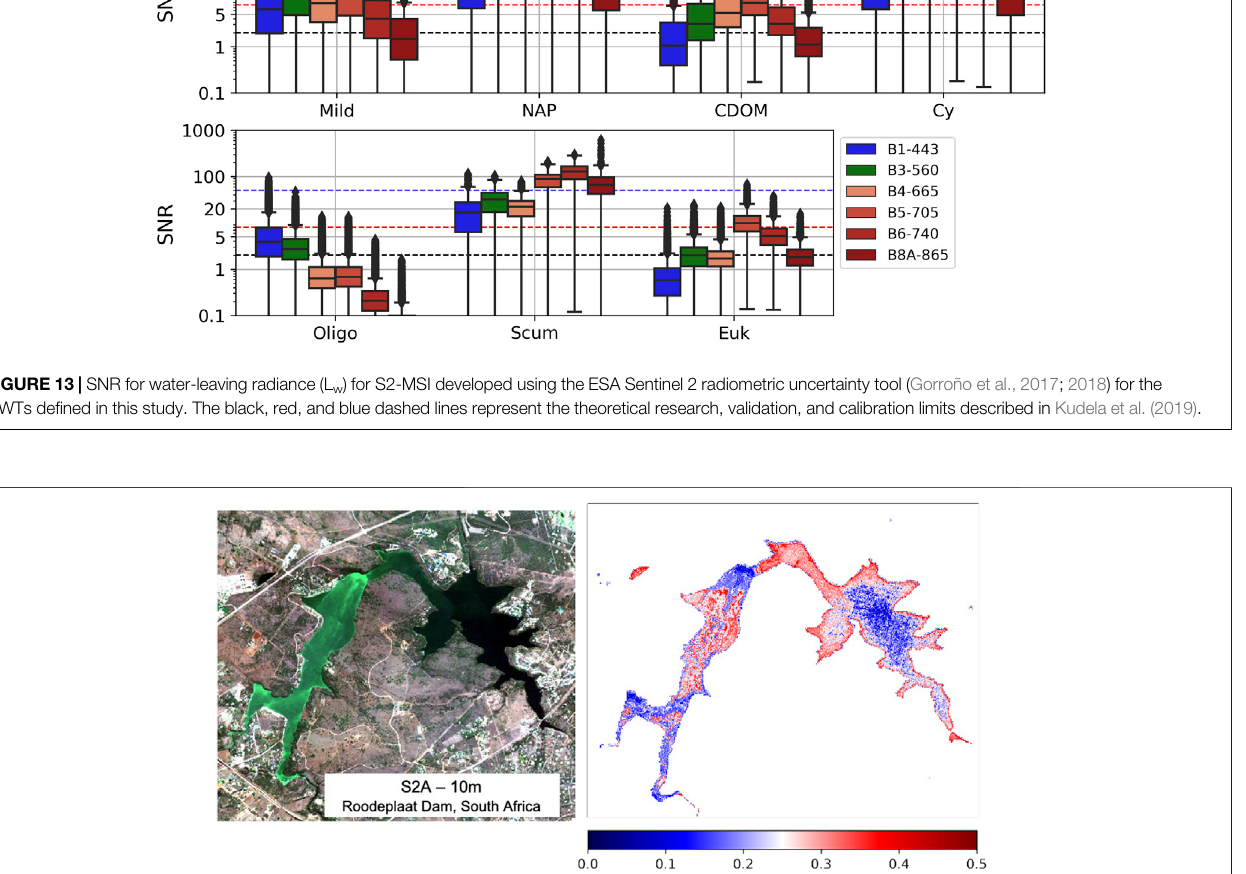
Frontiers in Environmental Science |